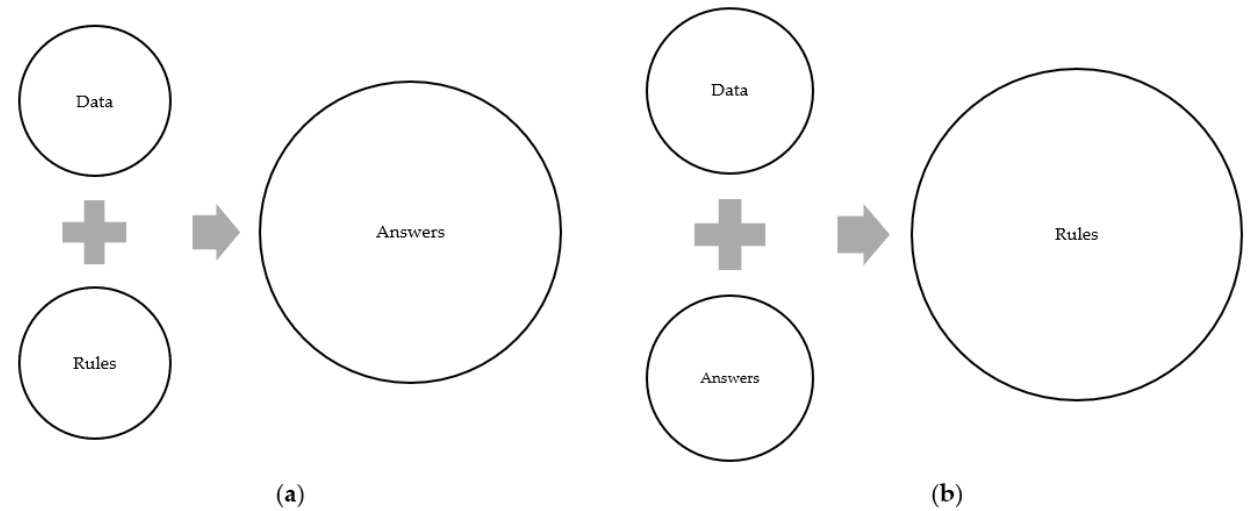
Figure 1. The Algorithm of different programming types: ( a ) the CP method; ( b ) the AI program- ming method.